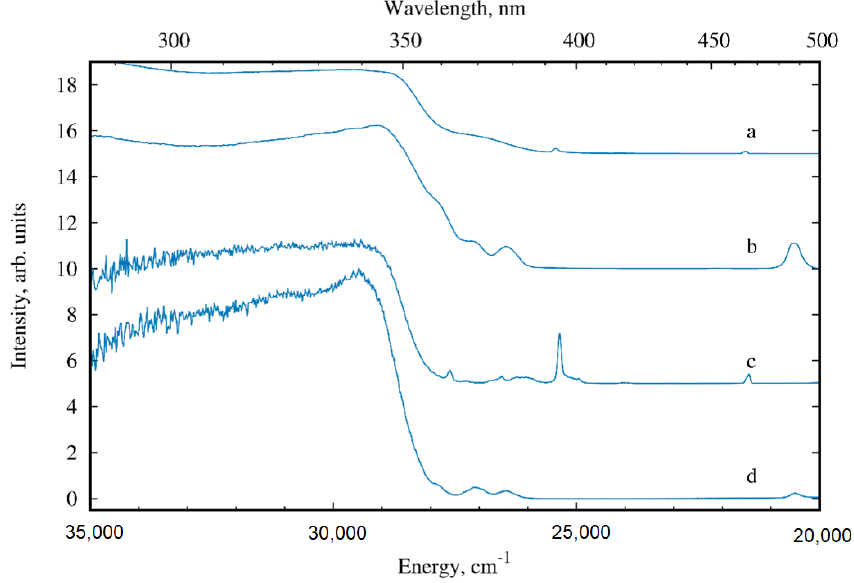
Figure 8. Excitation spectra of 2 Eu ( a ), 2 Tb ( b ), 3 Eu ( c ) and 3 Tb ( d ) at T = 300 K in solid state.